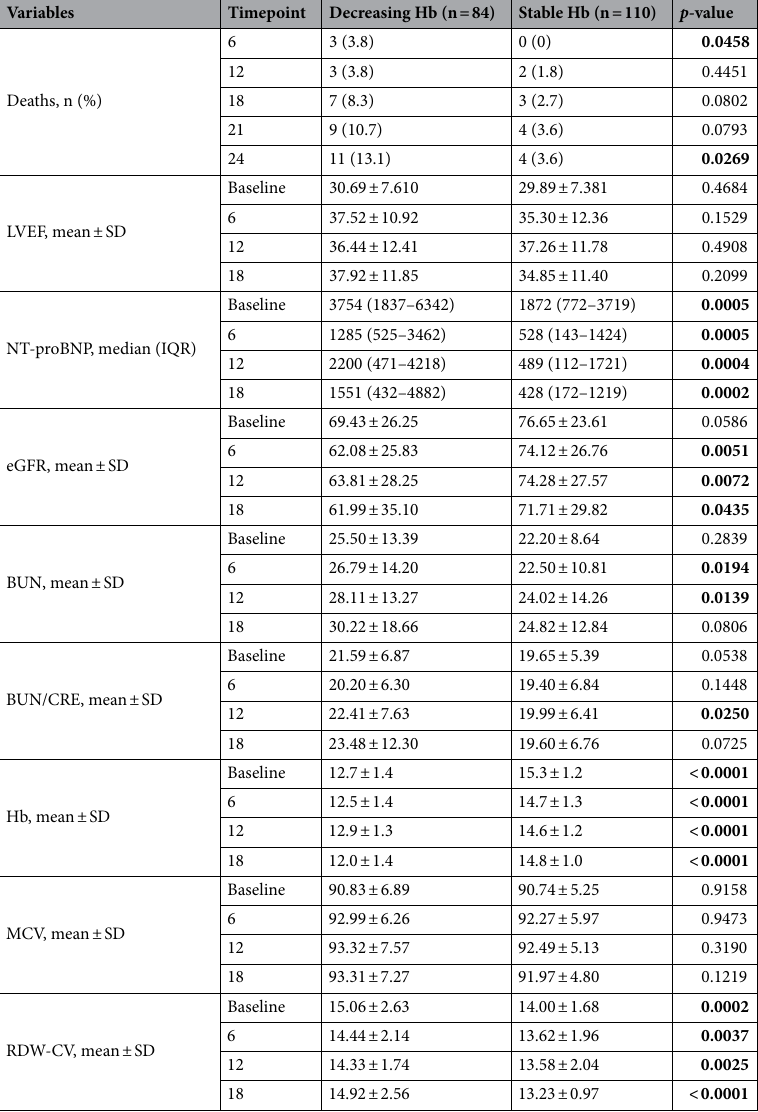
Table 4. Renal and cardiac function comparisons between “Decreasing Hb” group and “Stable Hb” group at baseline and at 6, 12, and 18 months after initiating S/V. BUN blood urea nitrogen, CRE serum creatinine, eGFR estimated glomerular filtration rate, LVEF left ventricular ejection fraction, MCV mean corpuscular volume, NT-proBNP N-terminal pro-B-type natriuretic peptide, RDW-CV red cell distribution width coefficient of variation. Significant values are in